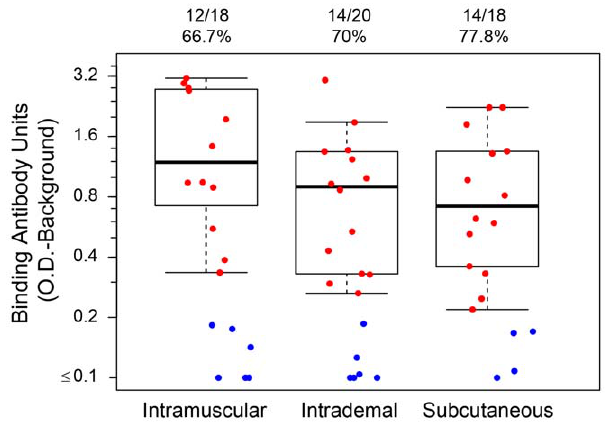
Figure 2. Anti-Env Binding antibody response by administra- tion route at 4 weeks post Ad5 boost. Anti-Env binding antibody levels and % response are shown per route of administration. Positive responses are in red and non-responders in blue.